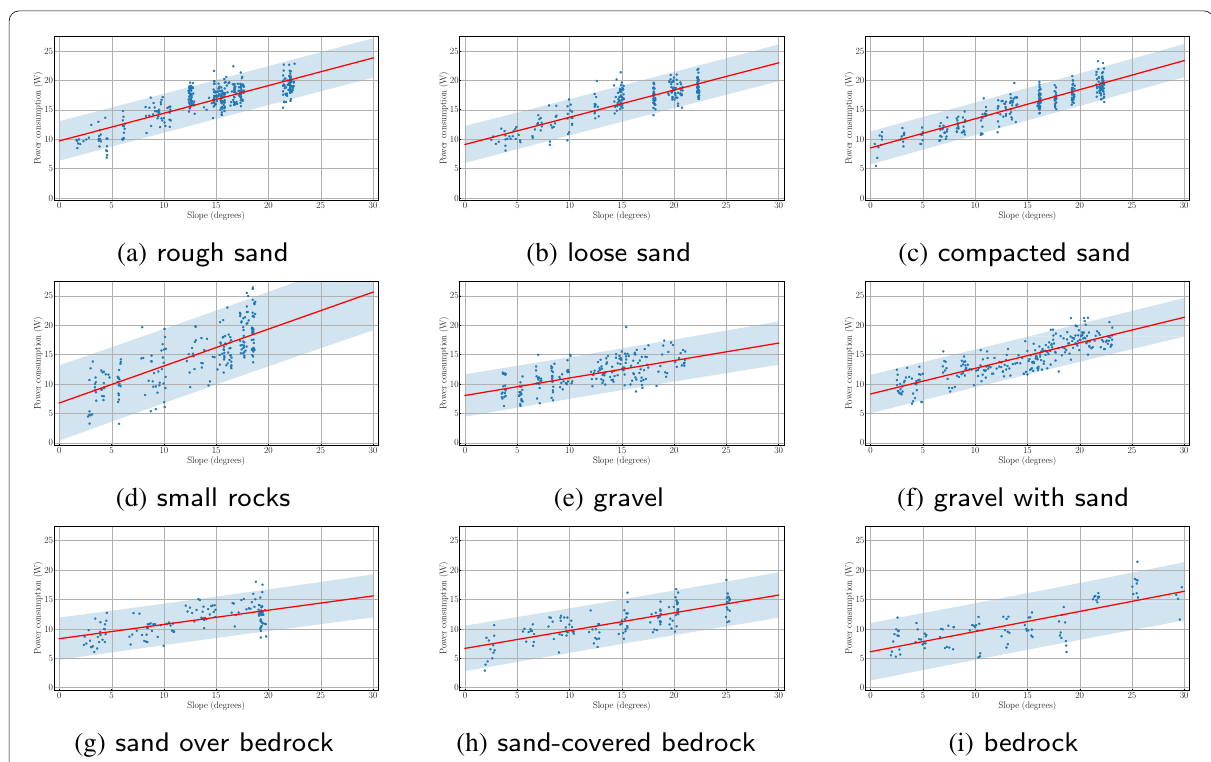
Fig. 7 Reference GP regression model for the power consumption vs. slope characteristics of each surface class. Each model was learned from 75% of all the data in the corresponding surface domain. The red curve represents the predictive mean while the blue-shaded area represents the confidence interval with 2-standard deviation around the